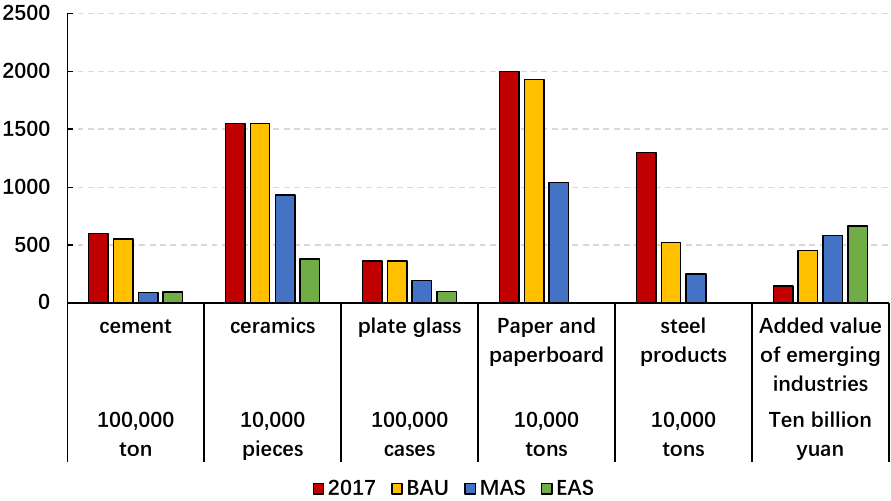
Figure 2. Demand of industrial development of PRD under the base year and three scenarios in 2035.